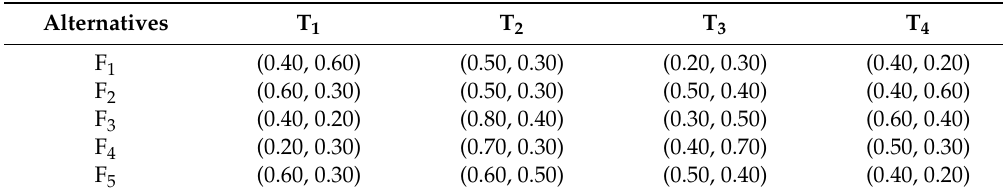
Table 9. Pythagorean fuzzy matrix by DM 4.